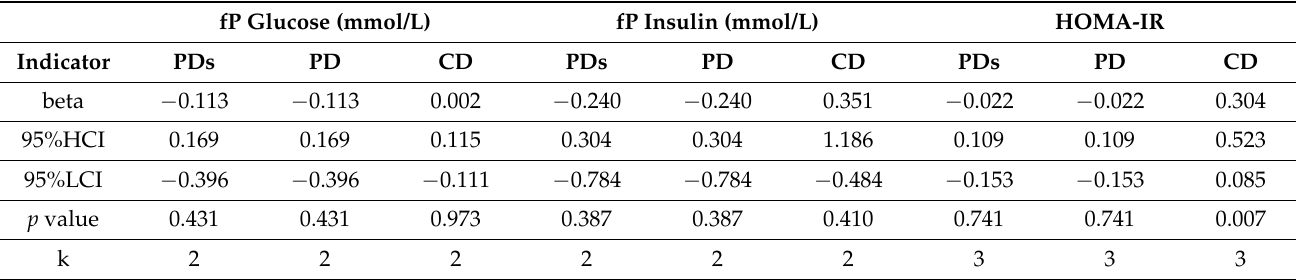
Table 9. Changes in carbohydrate metabolism (fP glucose, fP insulin, and HOMA-IR) in long-term PDs, PD, and CD studies (over 6 months). fP Glucose